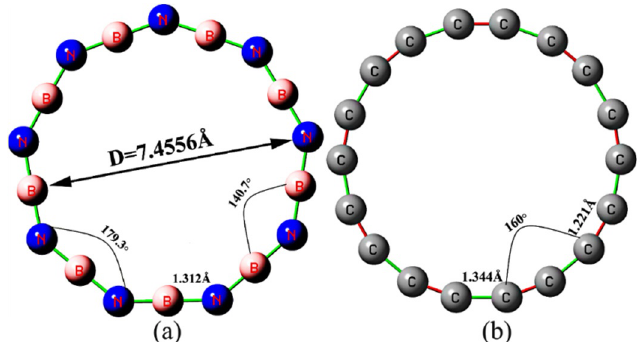
Figure 1. Structure of the optimized B 9 N 9 ( a ) and cyclo[18]carbon ( b ) molecule based on ω B97XD/def2-TZVP